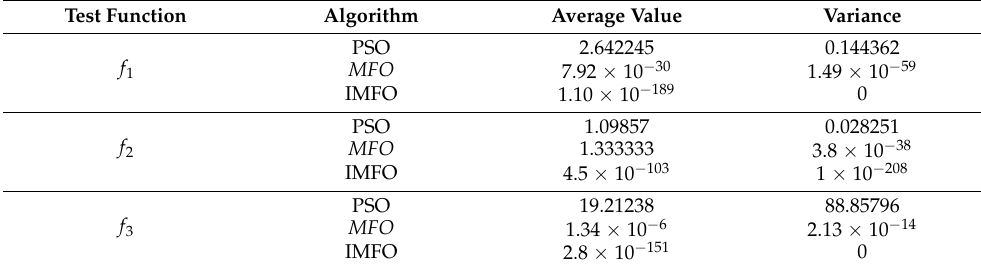
Table 3. Test results of